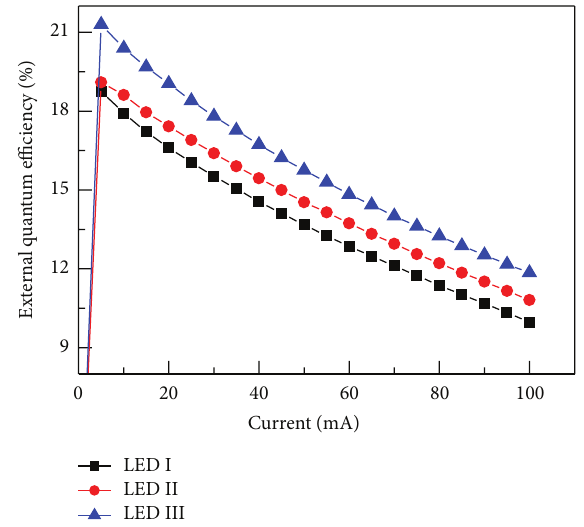
Figure 3: EQE as functions of injection currents for LEDs I, II, and